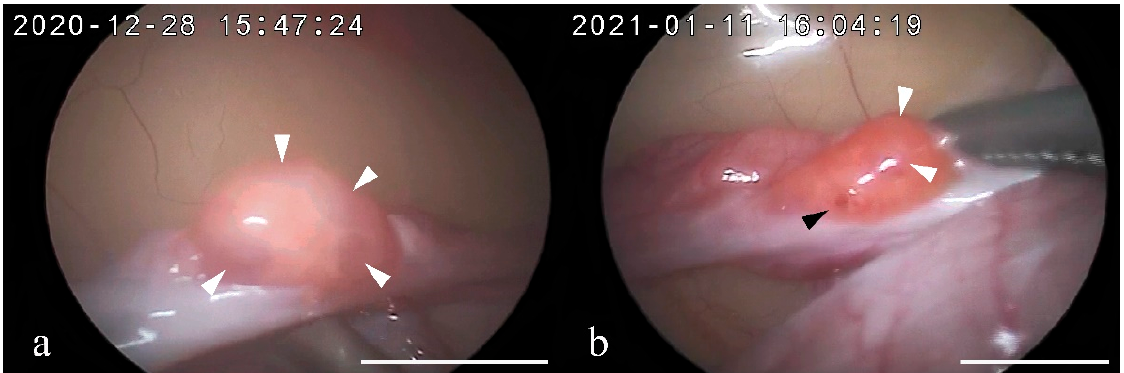
Figure 3. Representative pictures of the ovary observed through laparoscopy in the two Tsushima leopard cats after stimulation with 200 IU equine chorionic gonadotropin followed by 1000 IU porcine luteinizing hormone (pLH) 96 h later. Observations were made 32 h post-pLH administration: ( a ) female 1, right ovary; ( b ) female 2, left ovary. White arrow and black arrow indicate follicles (diameter, ≥ 2 mm) and corpus hemorrhagicum, respectively. Bar = 10 mm.